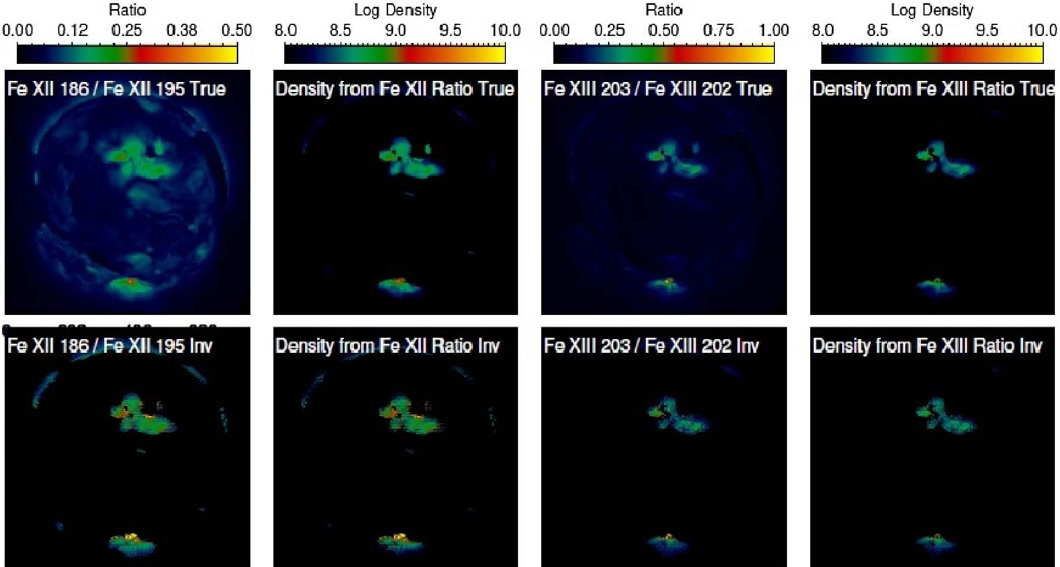
Fig. 7. Results of the wavelength unfolding via inversion. Comparison shows the full Sun ratio of the Fe XII and Fe XIII lines from truth data (top row) and from inverted data (bottom row), as well as the coronal density determined from the Fe XII and Fe XIII